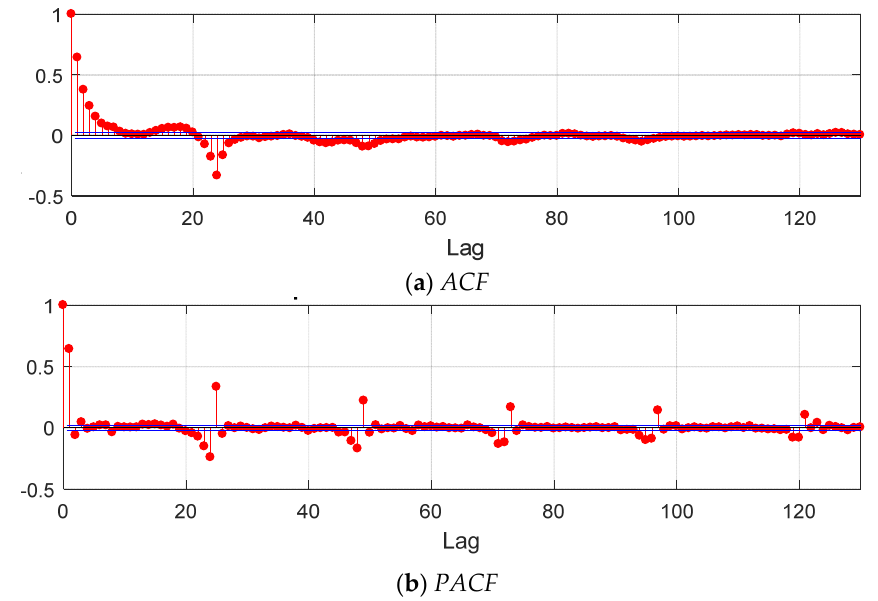
Figure 7. Autocorrelation and partial autocorrelation functions applied to SR.